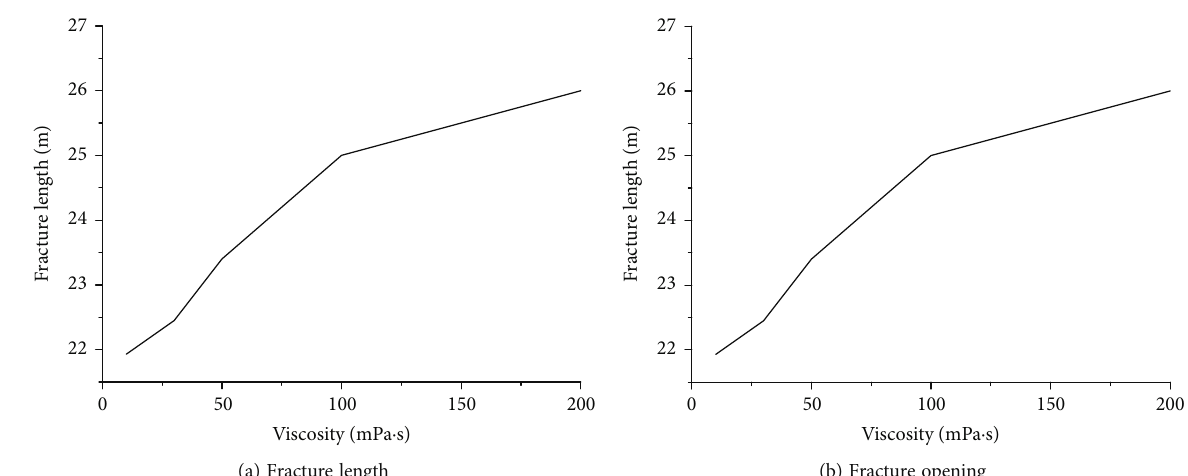
Figure 43: Fracture length and width at the NF approaching angle of 60 ° and under the acid viscosity of 10-200mPa · s.